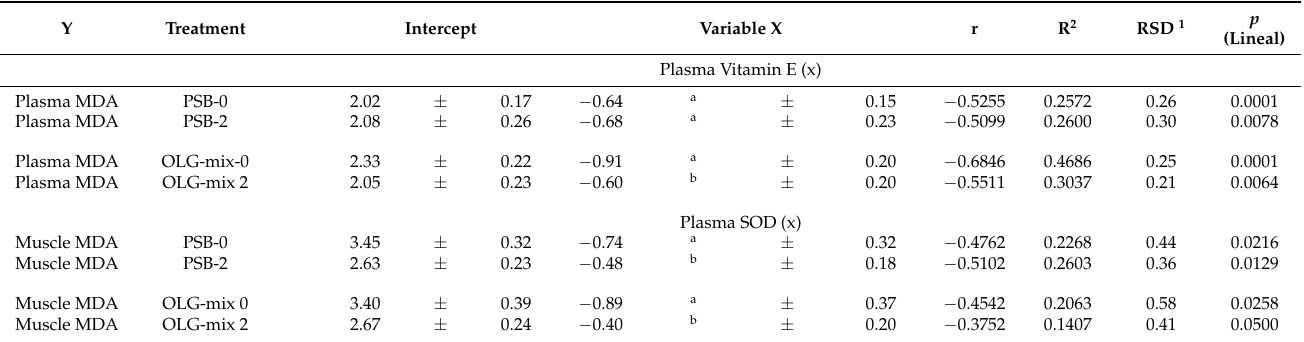
Table 8. Regression equations between plasma MDA concentration ( µ moles/L) and plasma vitamin E ( µ g/mL) or between muscle MDA (mg/kg) and plasma SOD according to the dietary supplemen- tation with protected sodium butyrate (PSB) or olive and grape-based by-product (OLG-mix). Intercept Variable